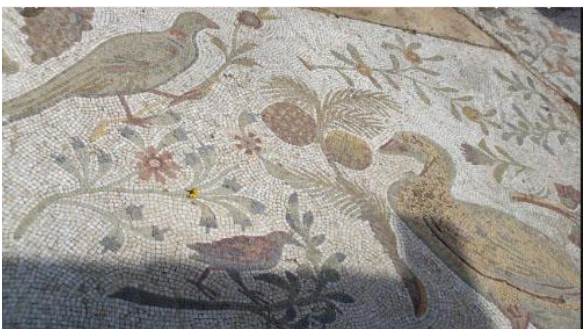
Figure 4- Mosaic of the villa of the aviary